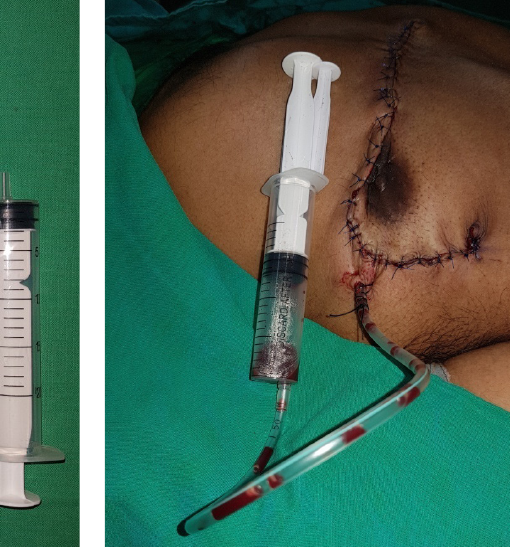
figure 1a. A plaster can be wrapped around the two plungers for stability.